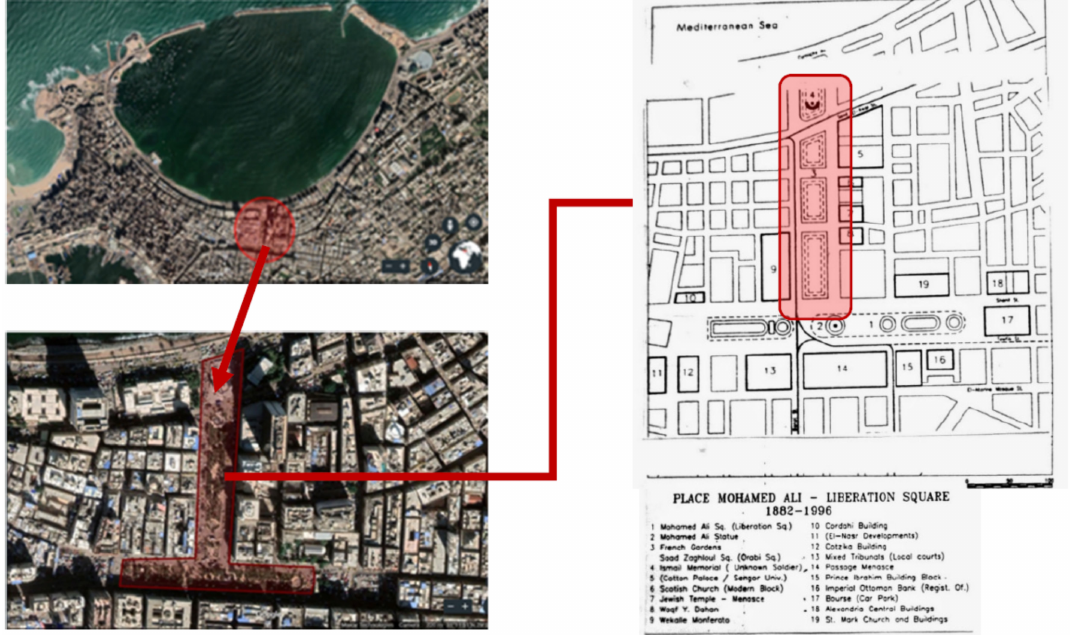
Figure 2. Left: Google Earth map with the two merged squares known as Place Mohamed Ali—highlighted and enlarged to show the current location of this urban space plan. Right: An old plan of Place Mohamed Ali with a highlighted section of the French Gardens Square through the time period 1882 and 1996. Source: Google Earth. The plan: